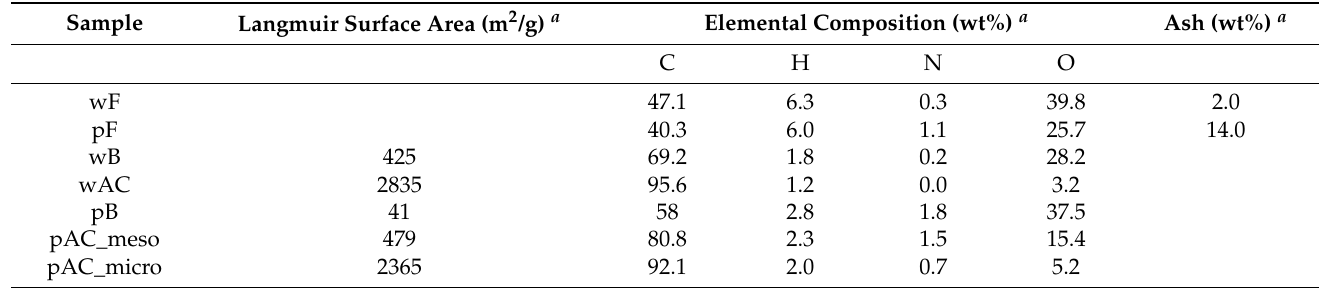
Table 1. Langmuir surface area and elemental composition of the samples under